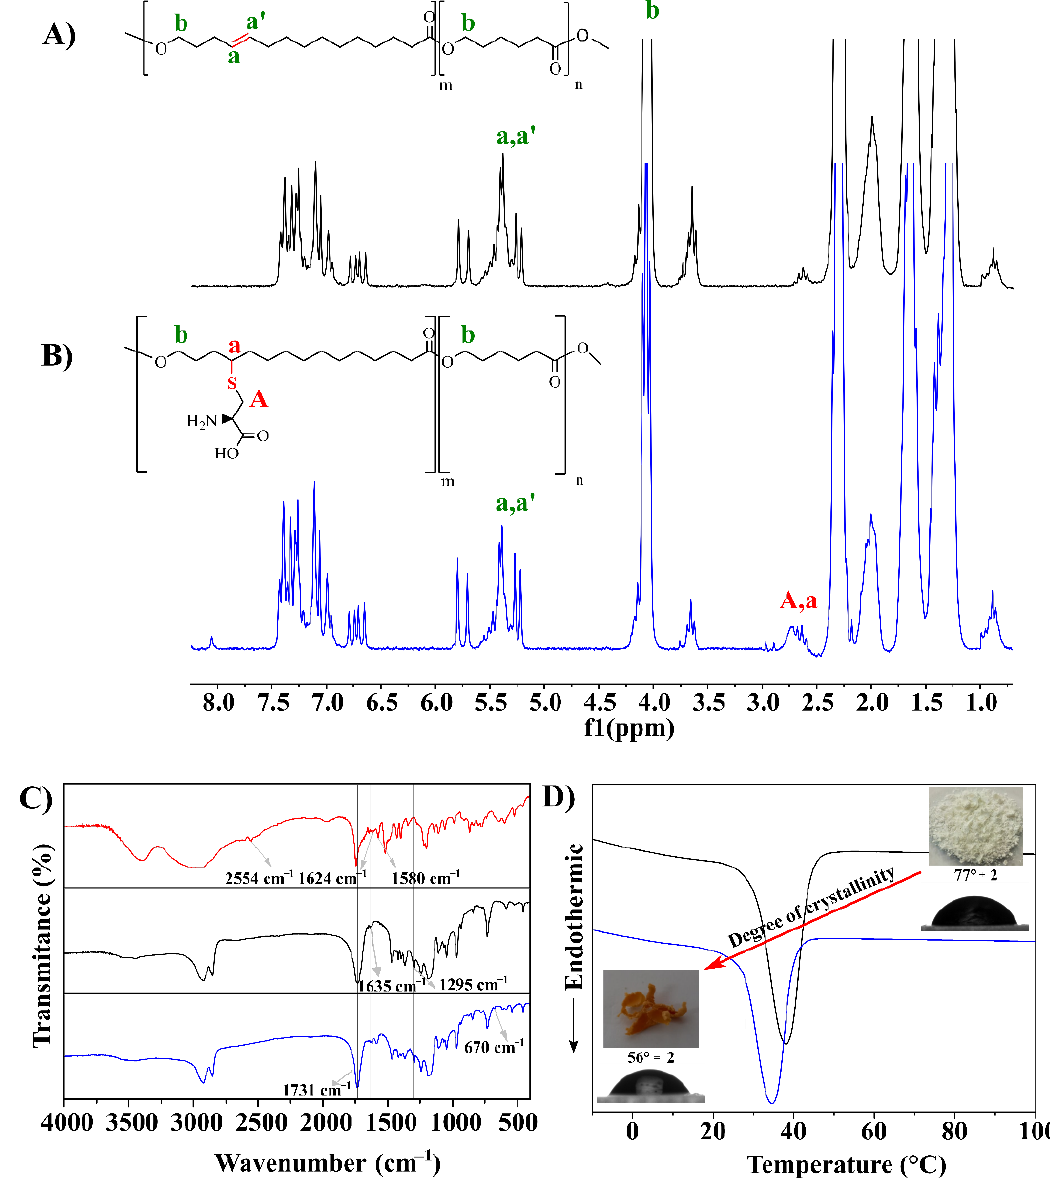
Figure 1. ( A ) 1 H NMR spectra of PGlCL with peak assignments ( a , a’ , b ). ( B ) 1 H NMR spectra of PGlCLCys (50/50 Gl/CL weight ratio) with peak assignments ( a , a’ , b, a, A ). ( C ) FTIR spectra of cysteine (red) and respective copolymers PGlCL (black) and PGlCLCys (blue). ( D ) Second run DSC heating curves of PGlCL (black) and PGlCLCys (blue) with different respective contact angle.3.2. Preparation of SPIONs Coated with PGlCLcys by Co-Precipitation Method.